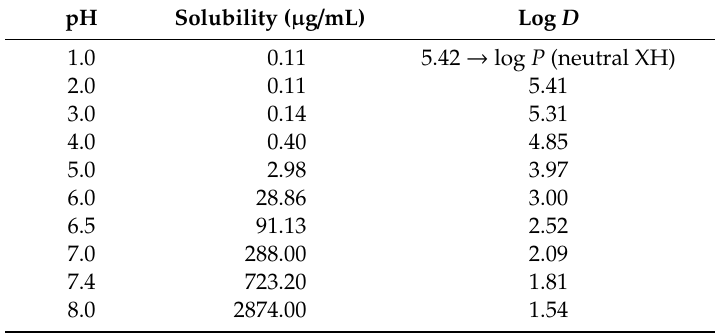
Table 2. PH-dependent solubility, partition coe ffi cient (log P ) and distribution coe ffi cient (log D ) of neat CorA determined by Pion’s T3